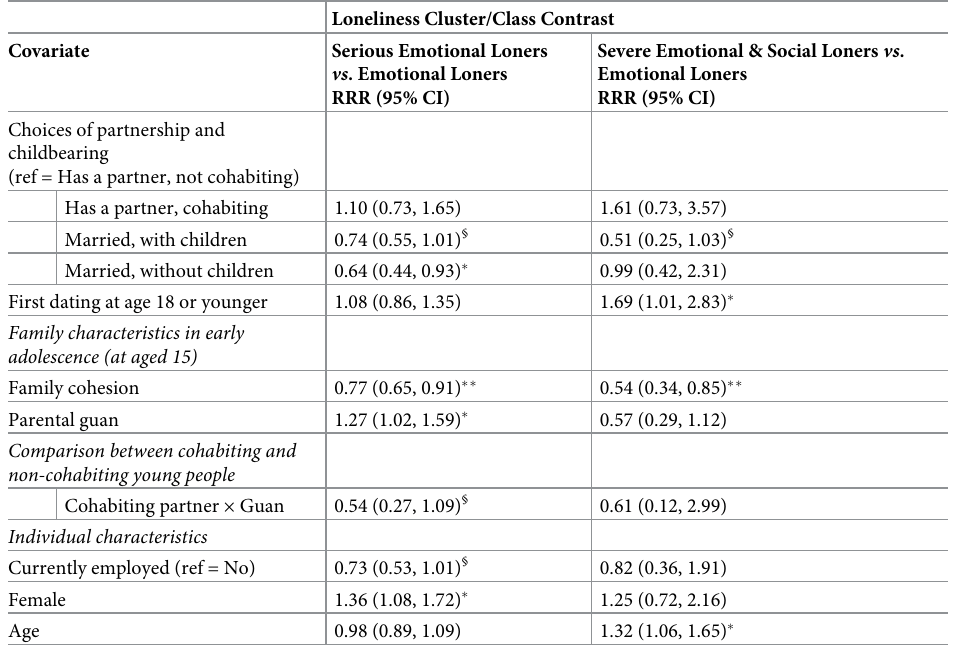
Table 4. Multivariate multinomial logistic regression results for family characteristics associated with latent structure of loneliness in young people with a partner, N =